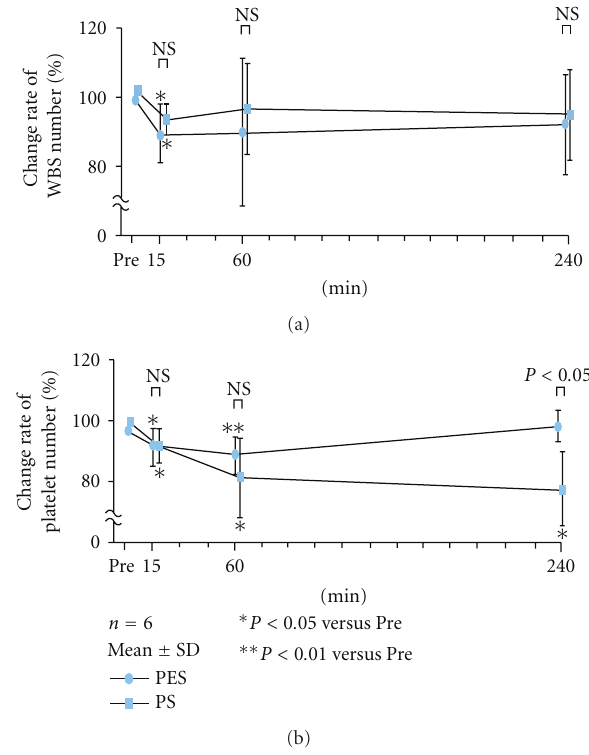
Figure 5: The change of WBC and platelet number during HD session by using PSE-150D (Nipro Co., Ltd., Osaka, Japan) and PS. Compared with PS, PES has excellent biocompatibility, in particular, relating to variation in platelet due to its high hydrophilicity (This figure is due to Dr. Nii’s